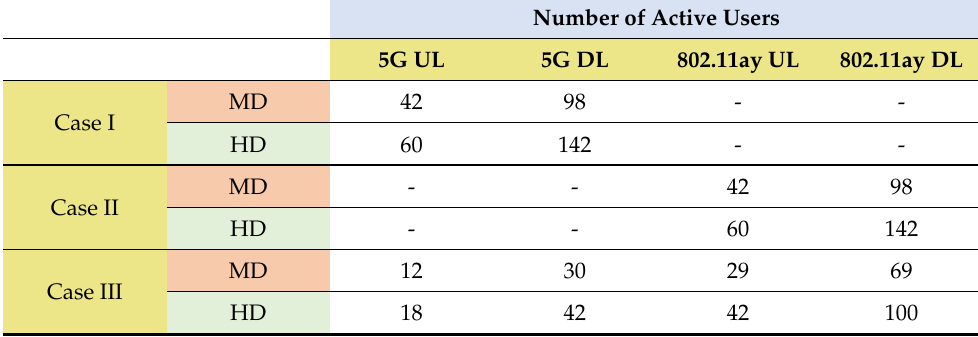
Table 4. Distribution of active users for the different considered cases for the medium user density (MD) and high user density (HD) within the